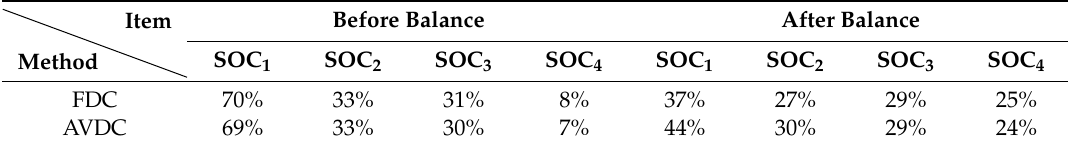
Table 5. Cell SOCs before and after balancing.